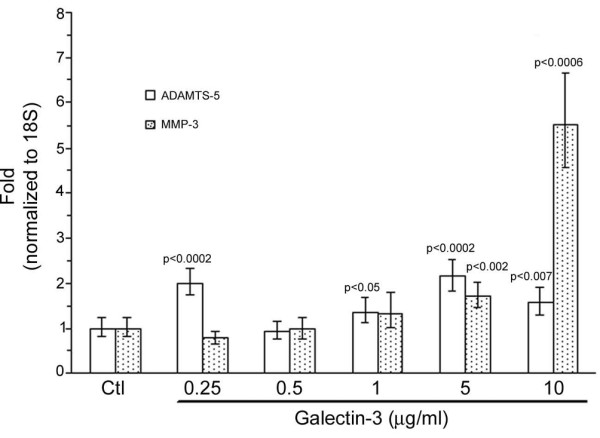
Effects of exogenous galectin-3 (gal-3) on human osteoarthritis chondrocytes. Chondrocytes were treated with increasing concentrations of recombinant human gal-3. Both ADAMTS-5 and matrix metalloproteinase (MMP)-3 expression were analyzed by real time RT-PCR. P versus control (Ctl); n = 5.